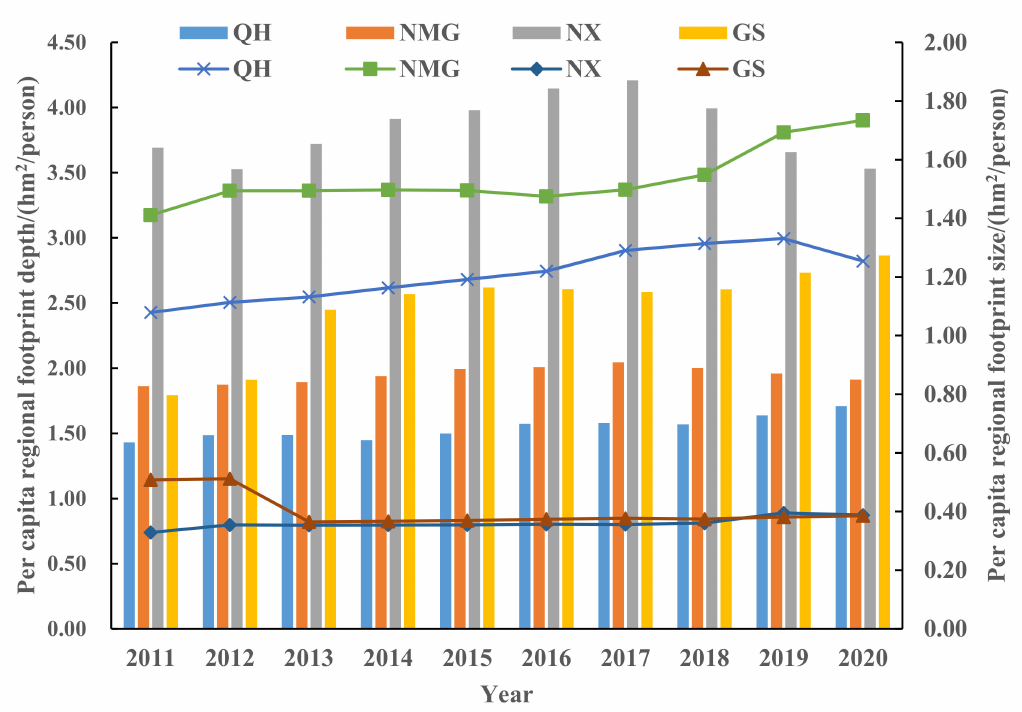
Figure 4. Changes of per capita regional footprint depth and regional footprint breadth in the upper reaches of the Yellow River from 2011 to